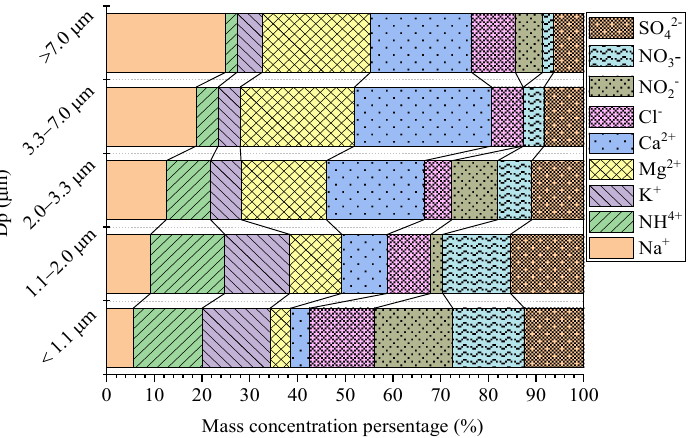
Figure 4. The percentage (%) of water-soluble inorganic ionic species for size fraction mass concentrations in Beijing.